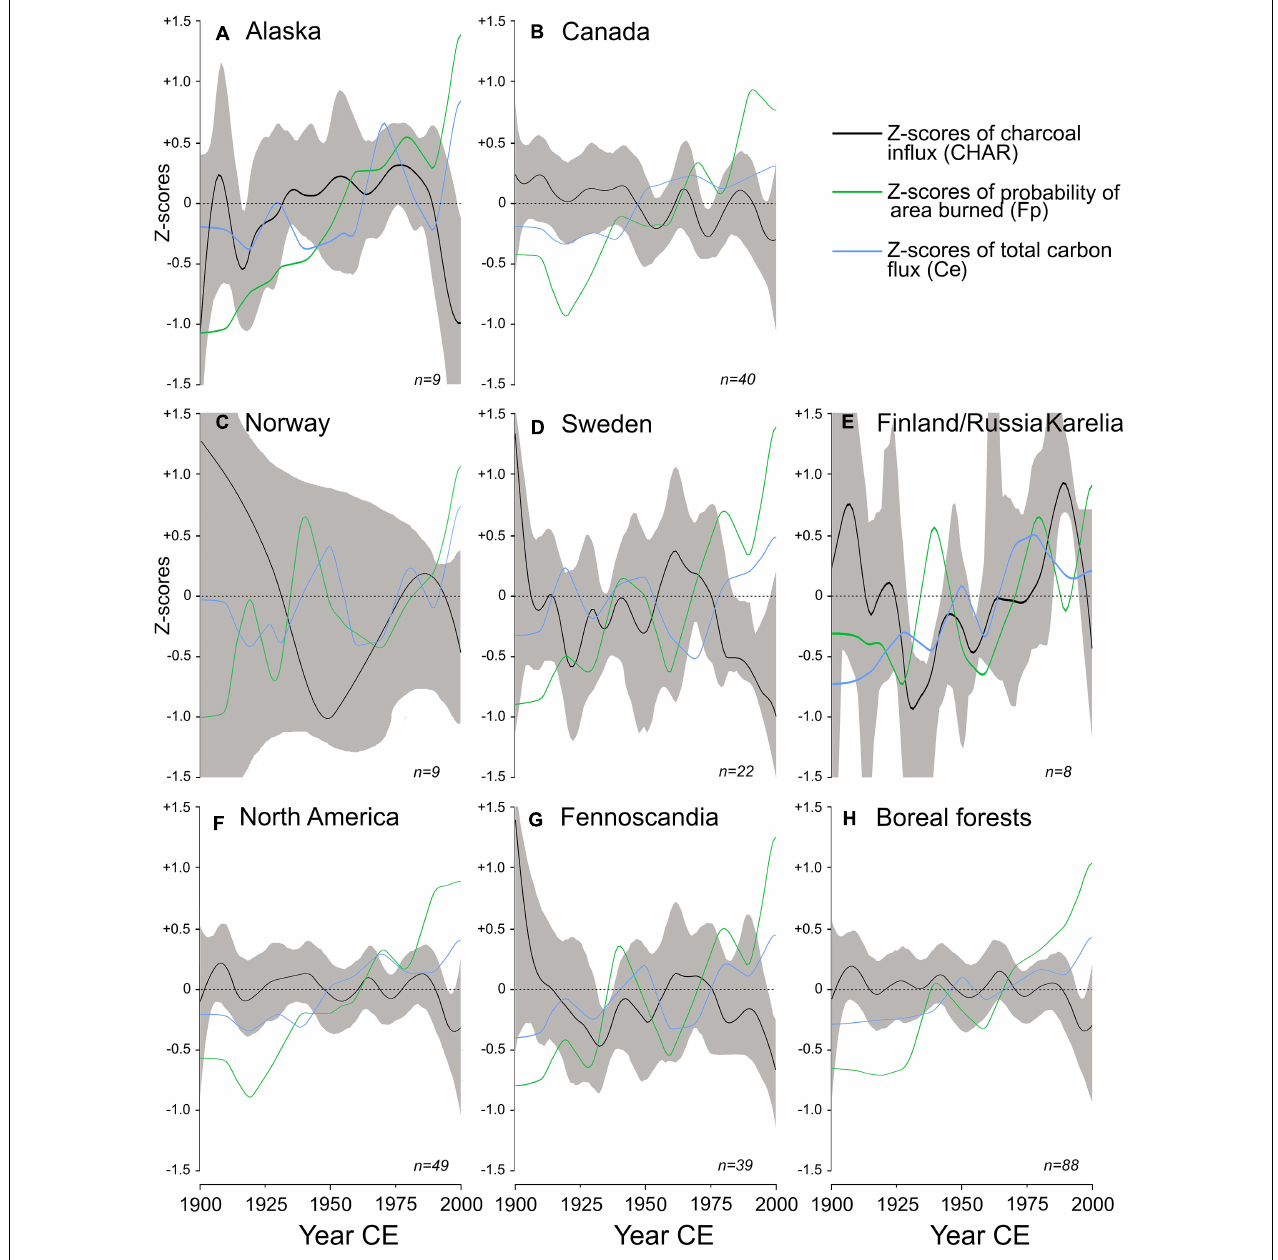
FIGURE 2 | Reconstructed charcoal-based and modeled (probability of annual area burned and total carbon flux emitted per year) boreal forests fire dynamics for the 20 th century for (A) Alaska, (B) Canada, (C) Norway, (D) Sweden, (E) Finland/Russia Karelia, (F) North America, (G) Fennoscandia, and (H) boreal forests, with the number of site contributing to the analysis for each sub-area. The composite curves have been smoothed using a 10-year window half width. Bootstrap 97.5% CI from resampling by charcoal records are shown as gray